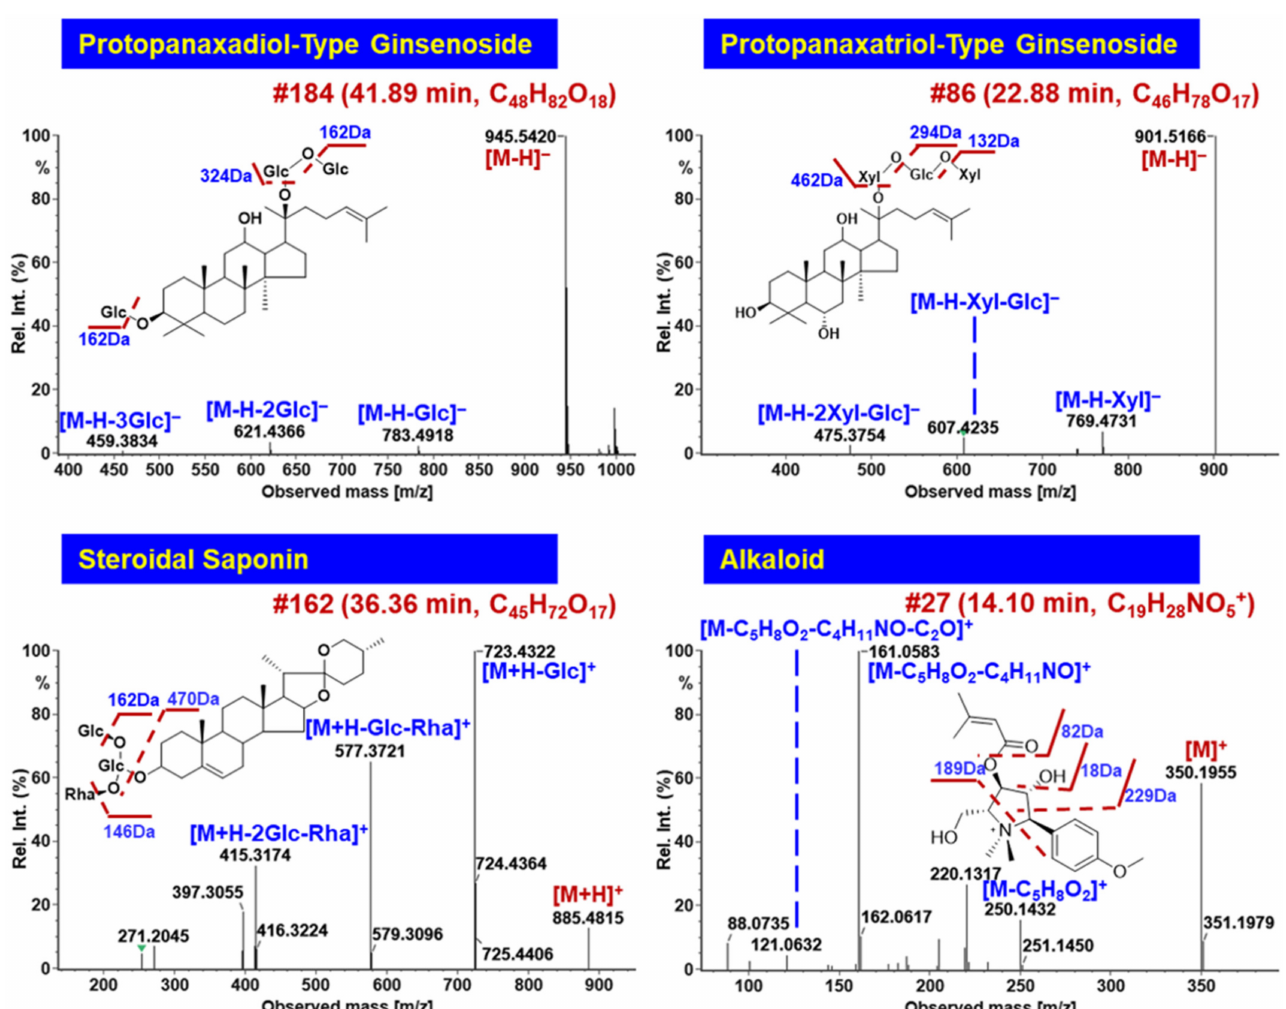
Figure 6. Annotation of the CID-MS 2 spectra of the protopanaxadiol (PPD) and protopanaxatriol (PPT)-type ginsenosides, steroidal saponins, and alkaloids from WXG using UNIFI TM , showing the characteristic fragmentations and their application to characterize the unknown